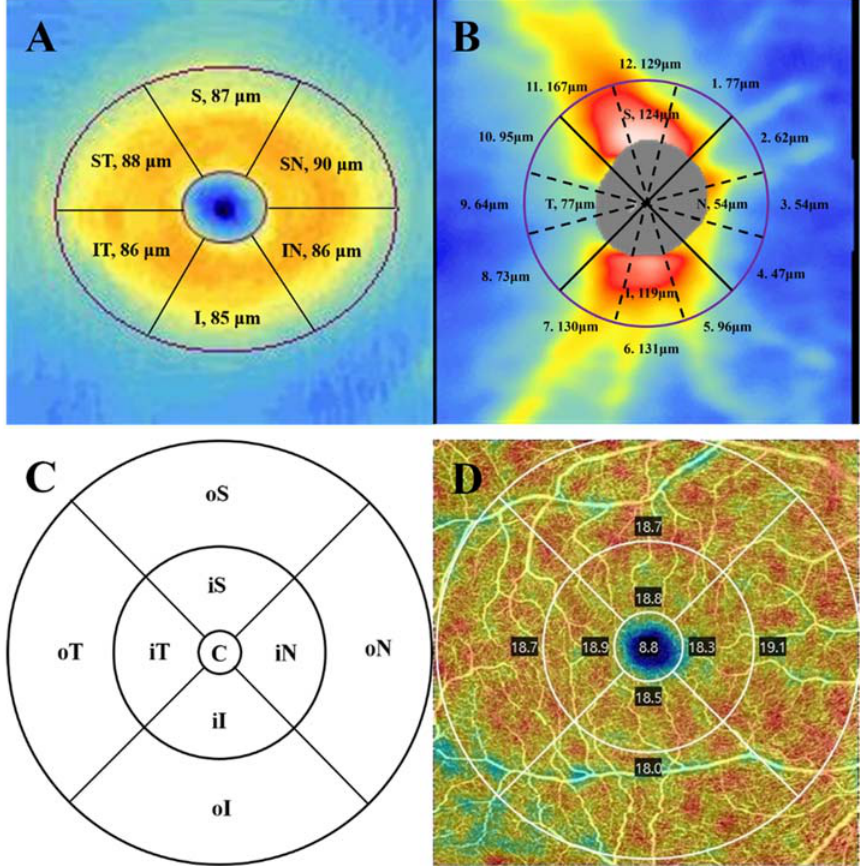
Figure 1. Retinal structural and vascular parameters in OCT and OCTA images of the right eye. ( A ) mGC/IPLT map with six sectors (solid line) in the 14.13 mm 2 elliptical area. ( B ) cpRNFLT map with four quadrants (solid line) and twelve clock ‐ hour zones (dotted line) in the 3.46 mm ‐ diameter circle scan (purple circle). ( C , D ) Diagrams of the macular SCP and the microvascular image. Numeric values in sectors or areas represent average values in the corresponding sectors or areas.